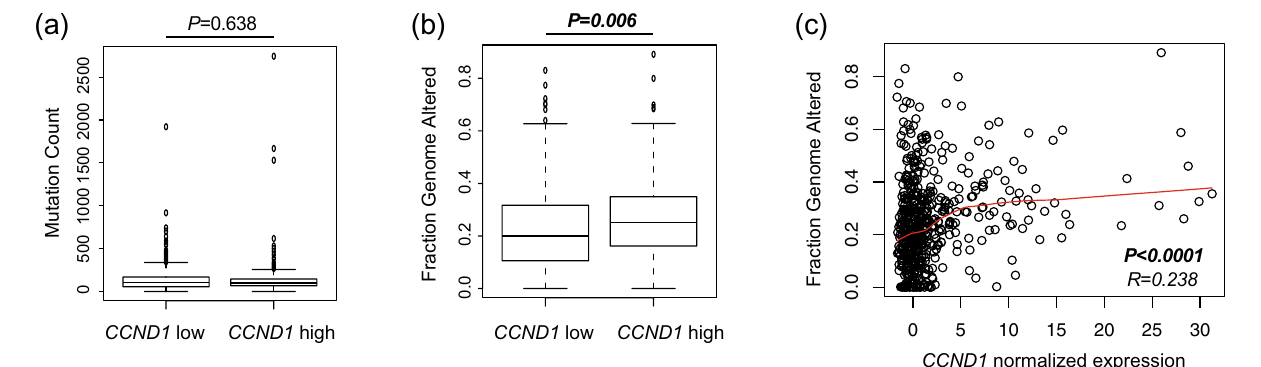
Figure 4. Genomic alterations in head and neck squamous cell carcinoma. Two genomic alterations, tumor mutation counts ( a ) and fraction genome altered ( b ), were compared between tumors with low CCND1 expression and tumors with high CCND1 expression. The cutoff value of high and low CCND1 expression was set as the median. The correlation between the expression of CCND1 and fraction genome altered ( c ) was